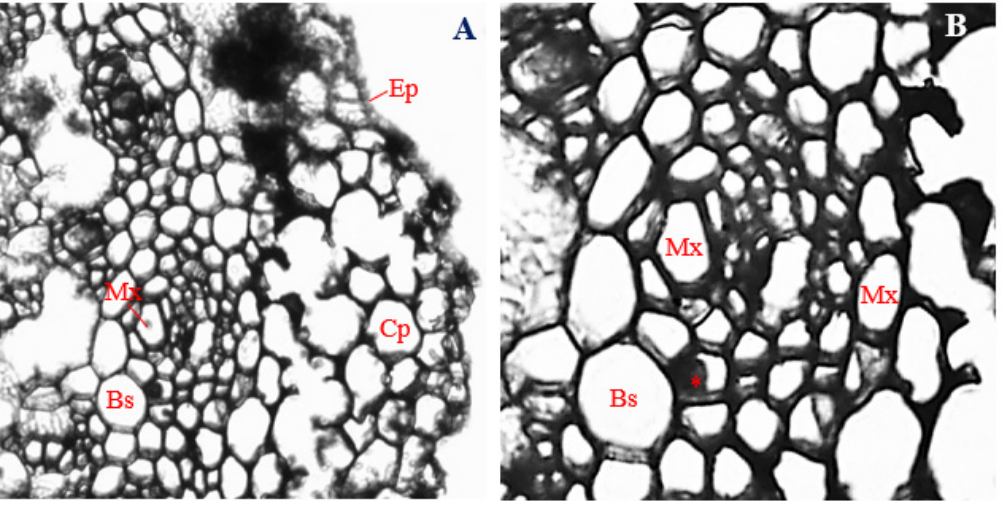
Figure 6. The transverse section of a corn stem infected with endophytic Fusarium verticillioides . ( A ) Magnification 200×; ( B ) magnification 400×. Ep, epidermis; Cp, cortical parenchyma; Mx, metaxylem; and Bs, bundle sheath. Occlusion of xylem parenchyma is marked with an asterisk (*).